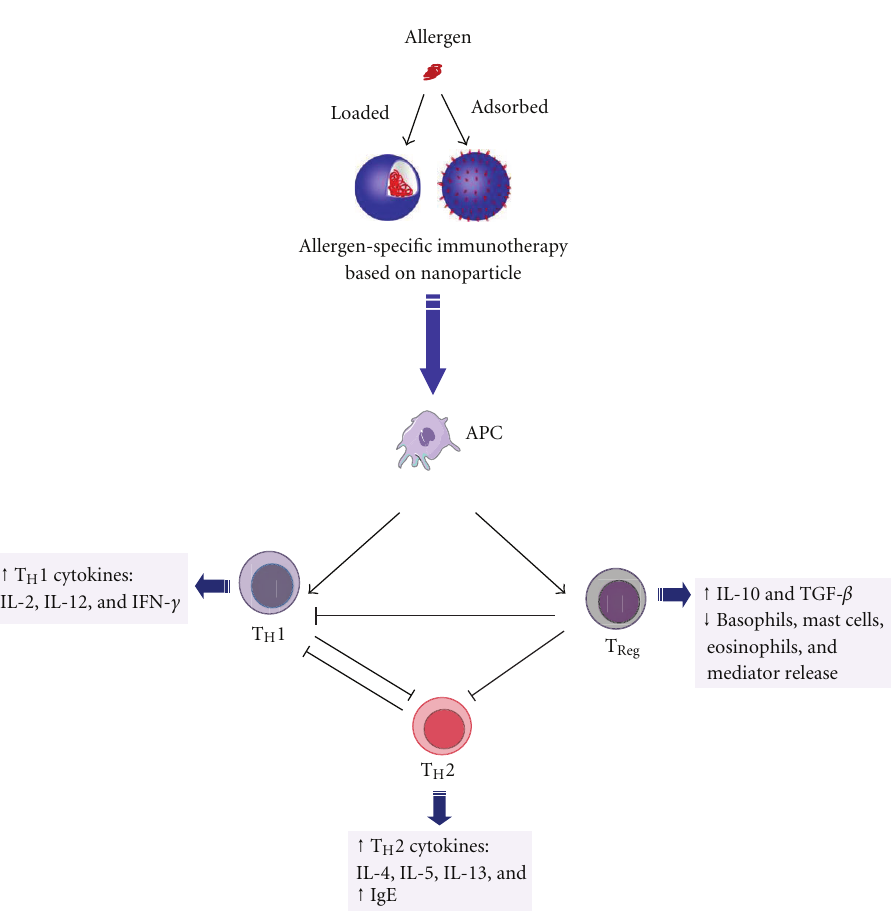
Figure 2: Immunomodulation of allergic diseases by using nanoparticle-based vaccines. Immunological changes after successful allergen specific-immunotherapy are indicated by whole arrows; truncated arrows indicate inhibitory e ff ects. Redirection of allergic-T H 2 responses, in favour of T regulatory cell induction or/and T H 1 activation, are